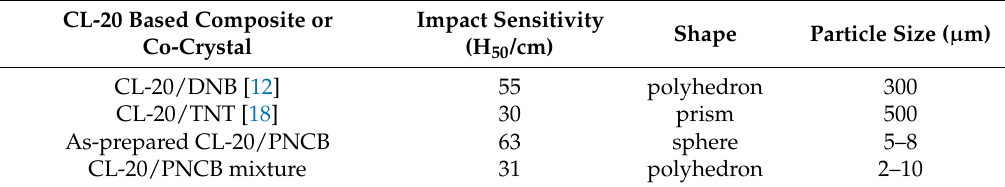
Table 1. Impact sensitivity of CL-20 based composite.